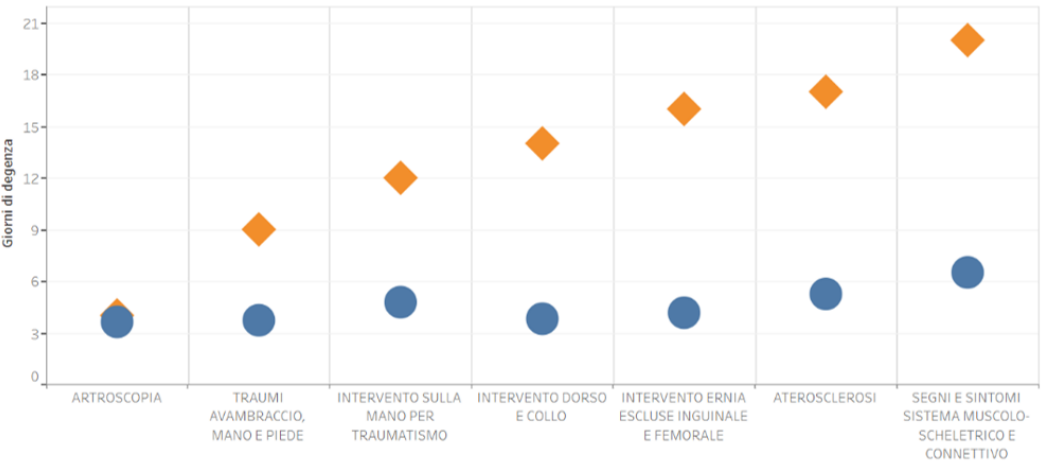
Figure 3. Visual chart with average number of days ( y -axis) by hospital of inpatient stays for some diseases and surgical operations (lower blue circle) and the average number of maximal days estimated for the same disease (upper orange diamond). Examples of depicted surgical operations are arthroscopy, and back, hernia, and hand